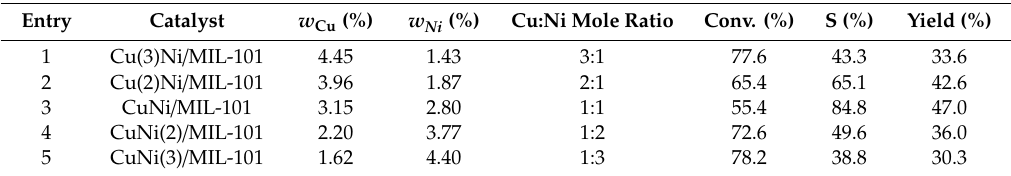
Table 4. The catalytic activity of Cu–Ni-supported catalysts in the selective oxidation of benzyl alcohol to benzaldehyde 1 . Entry